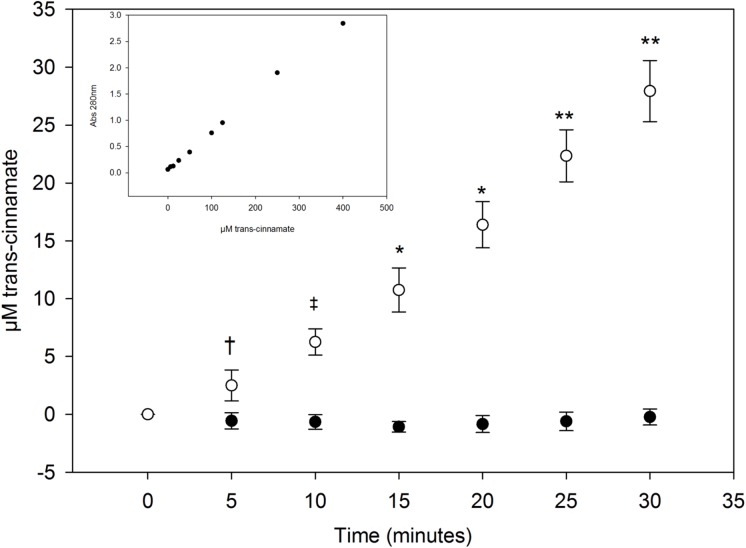
Trans-cinnamate production by cell line.Trans-cinnamate produced as a result of phe catabolism by vector control (pSLERGT) or pHENOMMenal (pHENOMM) cell lysates when held at 37°C. Time points 5, 10, 15, 20, 25, and 30 minutes showed significant production of trans-cinnamate in pHENOMMenal cell lysate compared to the control pSLERGT lysate (P < 0.05, 0.001, 0.0005, 0.001, 0.00025, and 0.0001 respectively). Each data point represents the mean of triplicate wells at 5 minute intervals starting at 0 minutes and ending at 30 minutes. Error bars indicate standard deviation. (Trans-cinnamate standard curve inset).